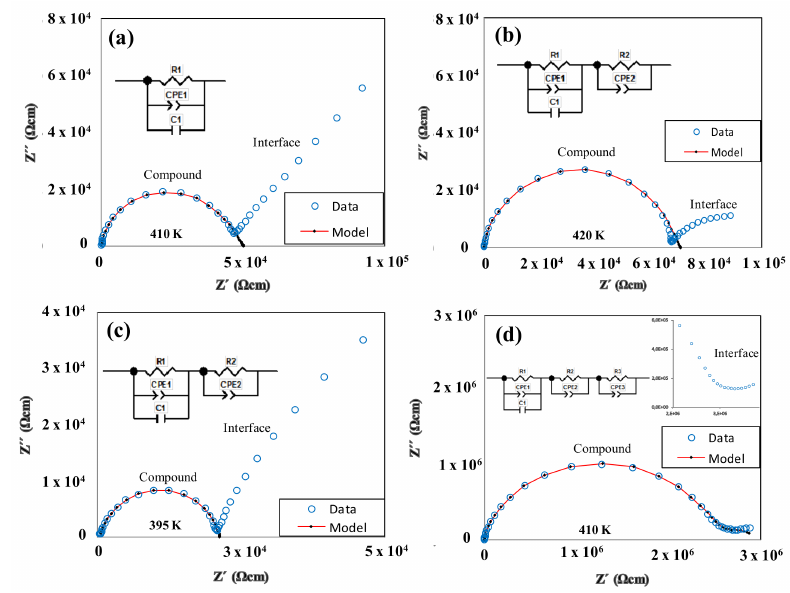
Figure 8. Representations of - Z” vs. Z (cid:48) for compounds: BF 4 -8,8 (7) ( a ); Cl-8,8 (2) ( b ); Cl-12,12 (3) ( c ); and OTf-8,8 (21) ( d